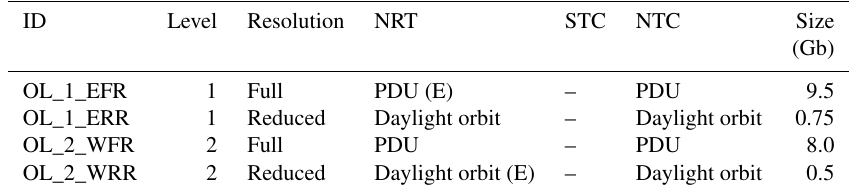
Table 3. Ocean Colour User Data Products (OLCI). All products are available from the monthly online rolling archive (ODA), and the long-term archive (DC) (see Sect. 3). EUMETCast dissemination is indicated by (E). Granularity: the products are provided as either 3min product data units (PDUs) or daylight orbits. The sizes are given for a full orbit and are an approximation based on compression assumptions and may slightly vary.